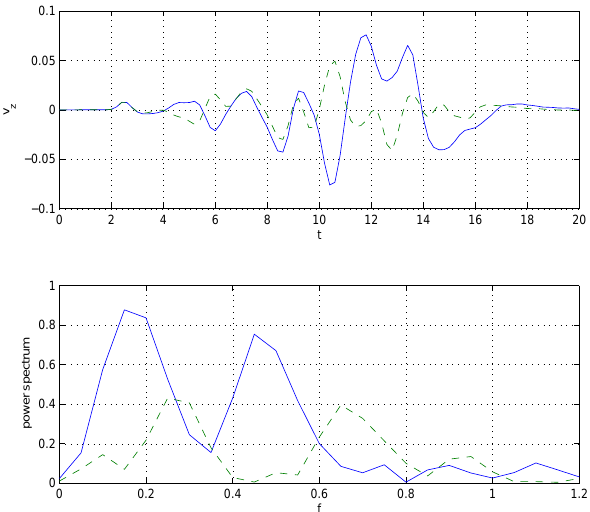
Fig. 6. A comparison between the power carried away by the ini- tial fast wave P trans (solid line) and the power P eg transported by the eigenmodes along the plasma sheet (dashed line) in the case of a pure 1-D-Harris sheet ( B z = 0). The initial energy is roughly equipartitioned between the two propagating waves with a slight advantage for the eigenmode